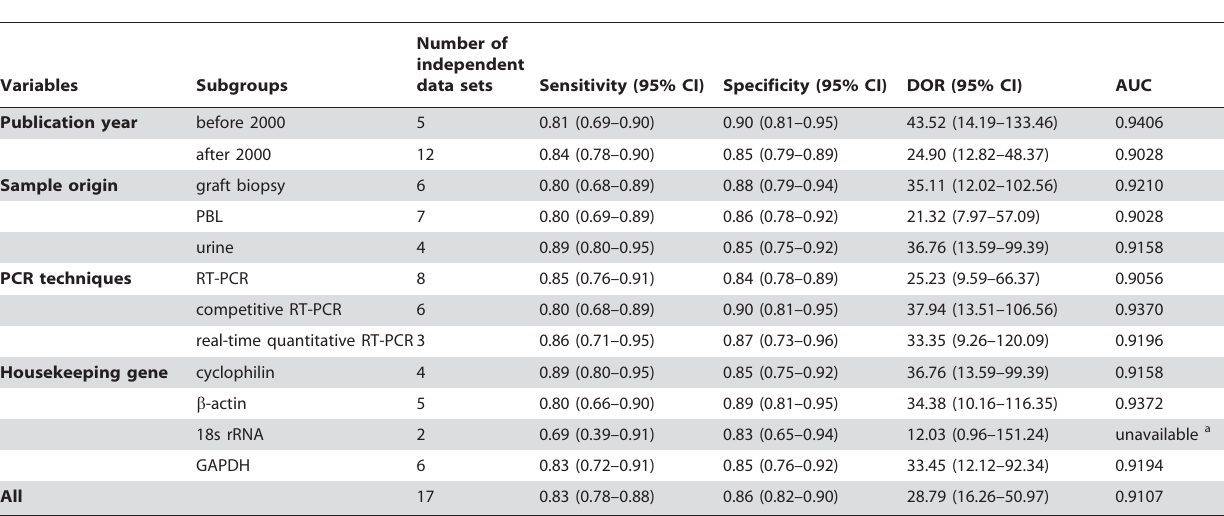
Table 2. Univariate analysis of potential variables influencing the test performance of perforin during AR.